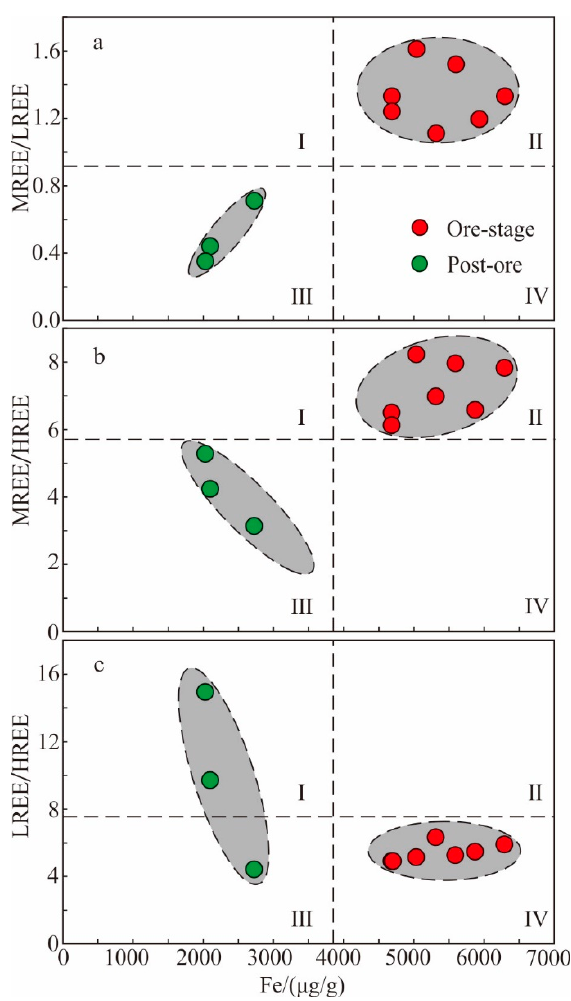
Figure 10. ( a ) MREE/LREE vs. Fe contents, ( b ) MREE/HREE vs. Fe contents, ( c ) LREE/HREE vs. Fe contents plot for calcites from the Zhesang gold deposit. ( a , b ) I, III, IV = non-prospecting area, II = prospecting area; (c) I, II, III = non-prospecting area, IV = prospecting area.